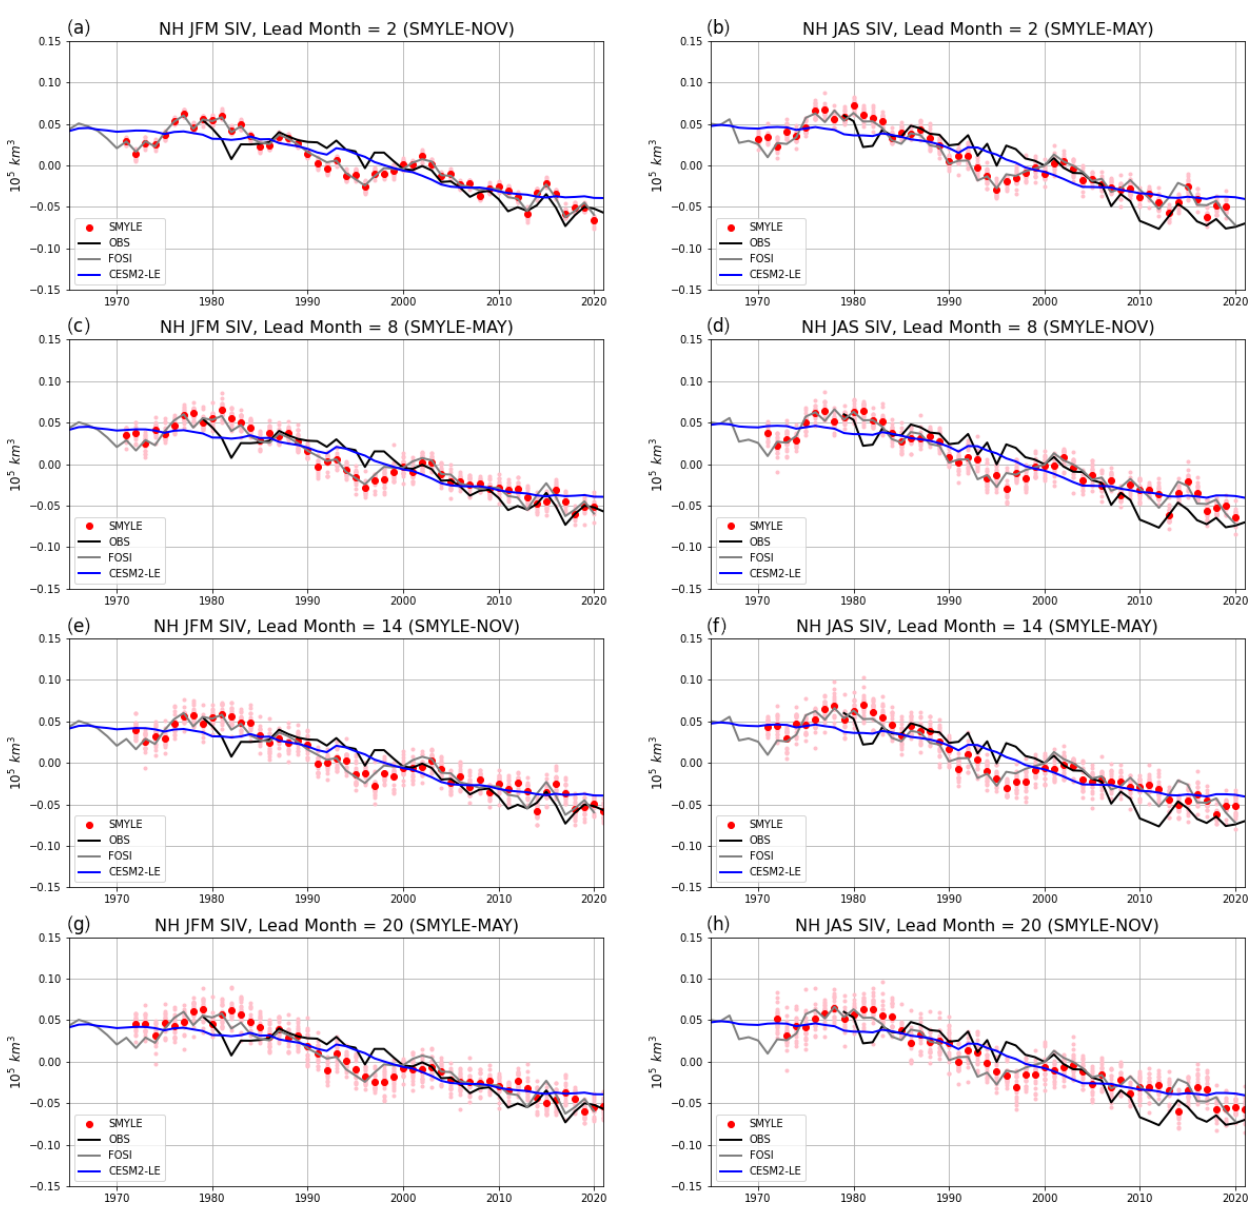
Figure 13. Northern Hemisphere seasonal sea ice volume (SIV) anomalies (relative to 1980–2015 climatology) for JFM (a, c, e, g) and JAS (b, d, f, h) from SMYLE (red and pink dots show ensemble mean and individual members, respectively), the PIOMAS reconstruction (black line; Schweiger et al., 2011), SMYLE-FOSI (grey line), and CESM2-LE (blue line; 50-member mean). Rows show results for lead months 2, 8, 14, and 20. Skill scores (correlation and normalized RMSE) are provided for SMYLE (red) and CESM2-LE (blue) relative to both PIOMAS and SMYLE-FOSI (scores in parentheses). Time series were detrended (over the window of overlap between SMYLE and the verification dataset) prior to computing skill